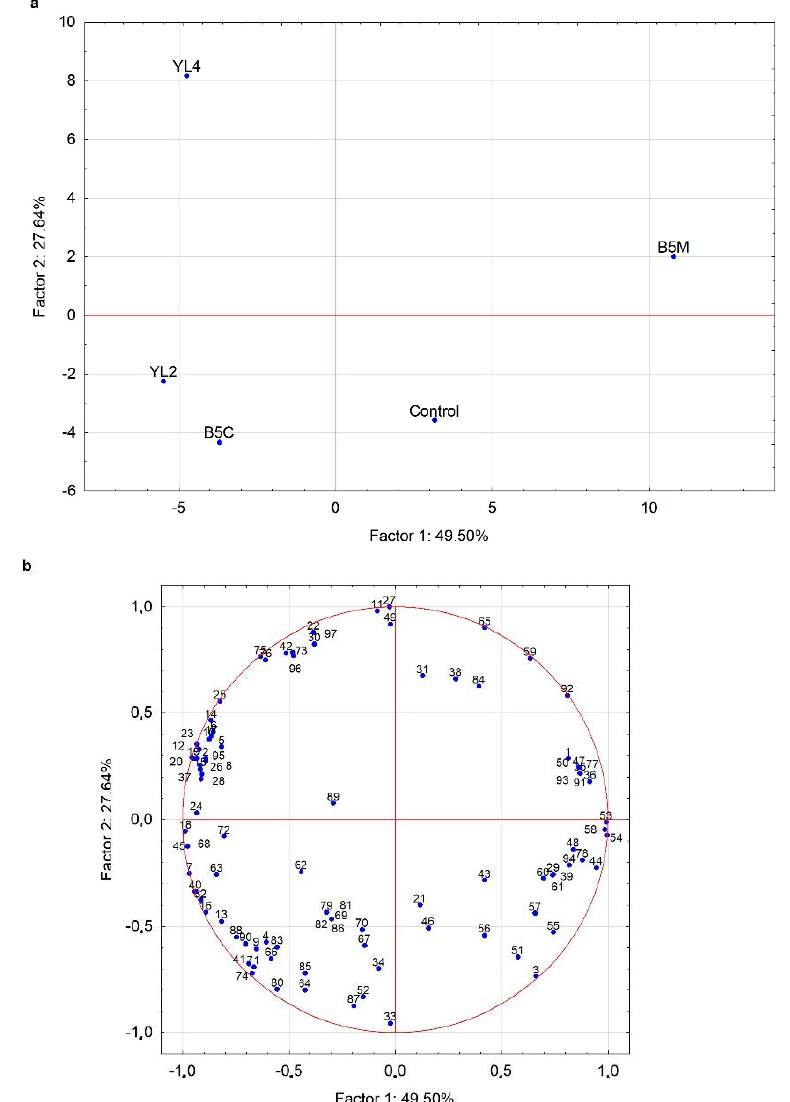
Figure 5. Plot of cases ( a ) and variables ( b ) obtained by PCA elaboration of the total volatile molecules characterizing the fish waste-based compounds obtained in relation to the strain employed. 1: